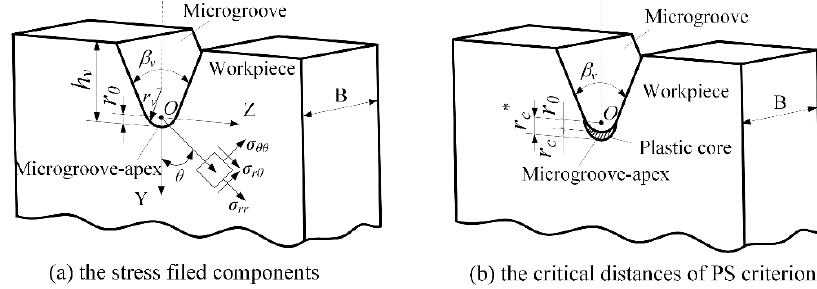
Figure 1. The stress field model in micro-crack induced severing along a microgroove-apex: ( a ) the stress filed components and ( b ) the critical distances of point stress (PS) criterion.